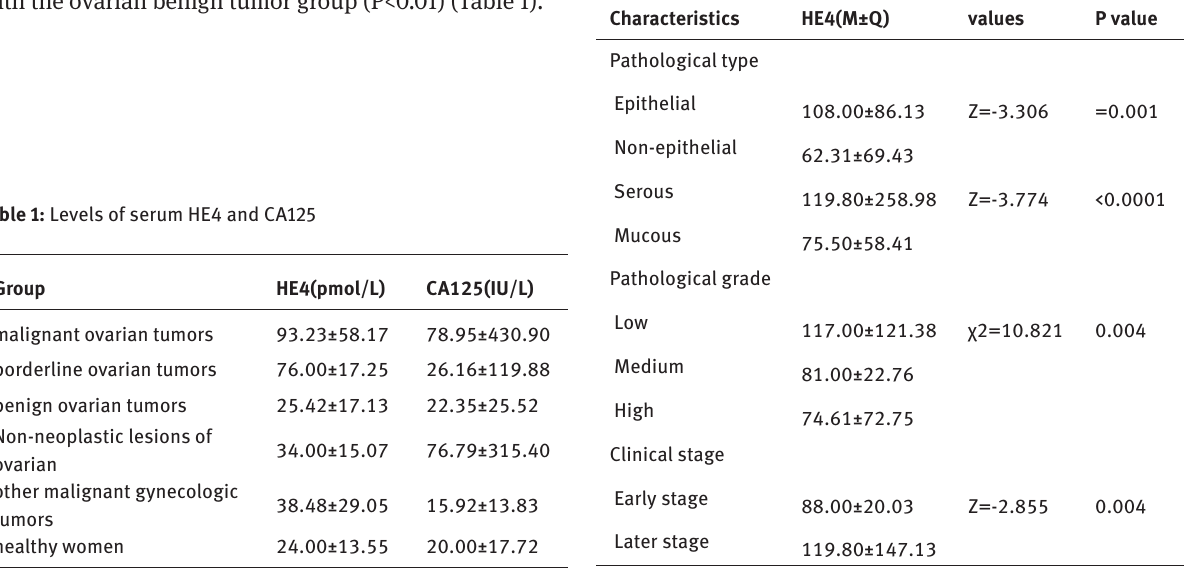
Table 1: Levels of serum HE4 and CA125